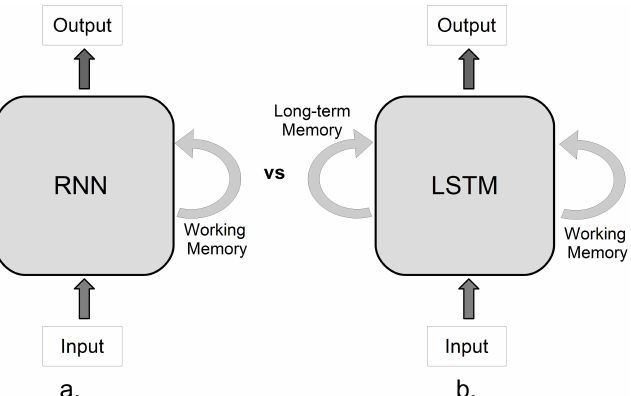
Figure 6. RNN v/s LSTM. ( a ): RNNs use their internal state (memory) to process sequences of inputs, ( b ): LSTM network is a variant of RNN, with additional long-term memory to remember past data.